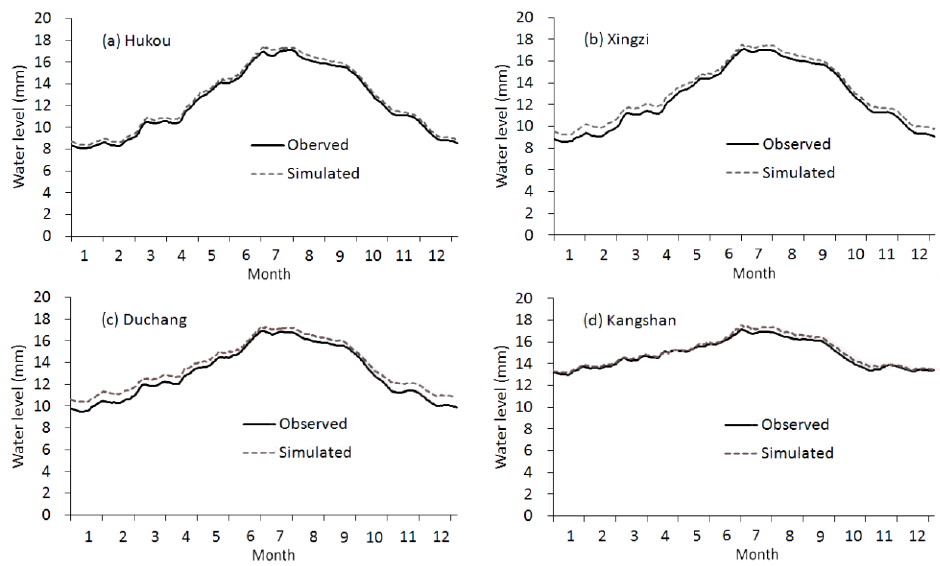
Figure 5. Comparison of observed and simulated lake water level during 2000–2011.